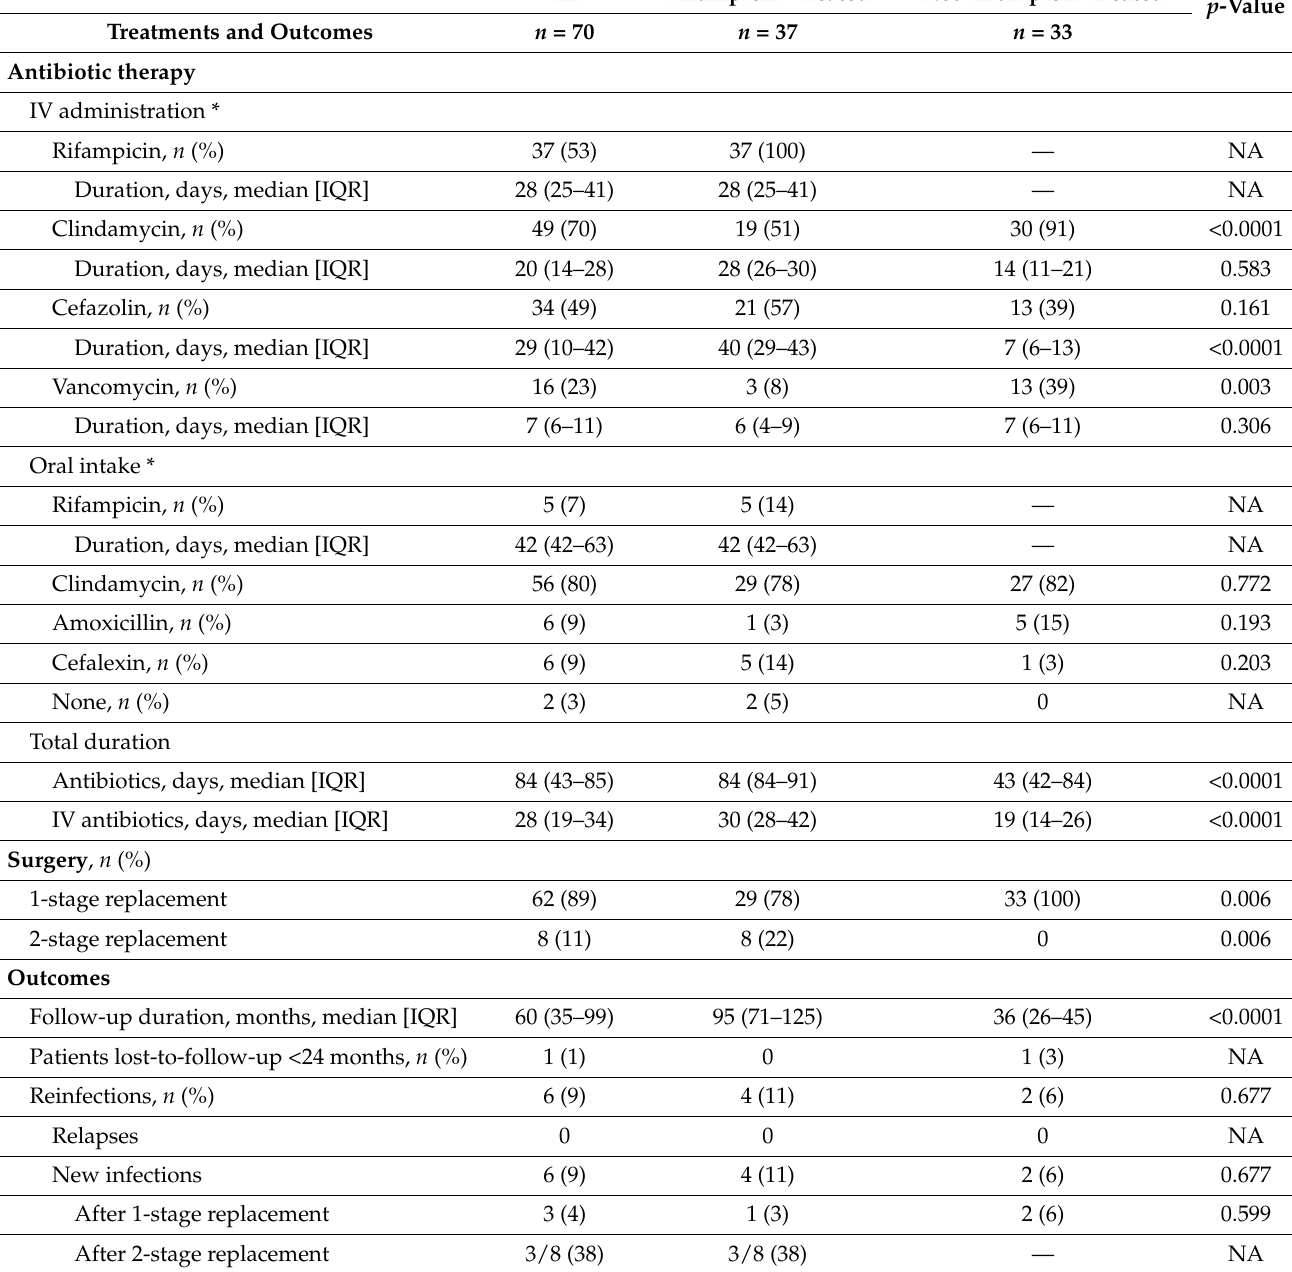
Table 2. Treatments and outcomes of patients treated for chronic C. acnes PJIs with rifampicin or